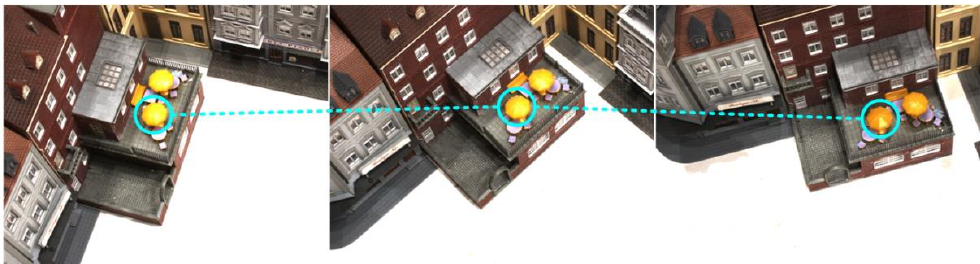
Figure 3. The photometric difference of different visual angles under the same